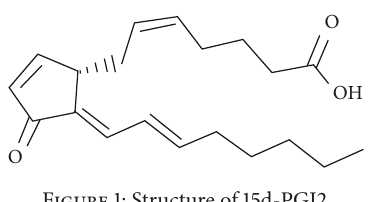
Figure 1: Structure of